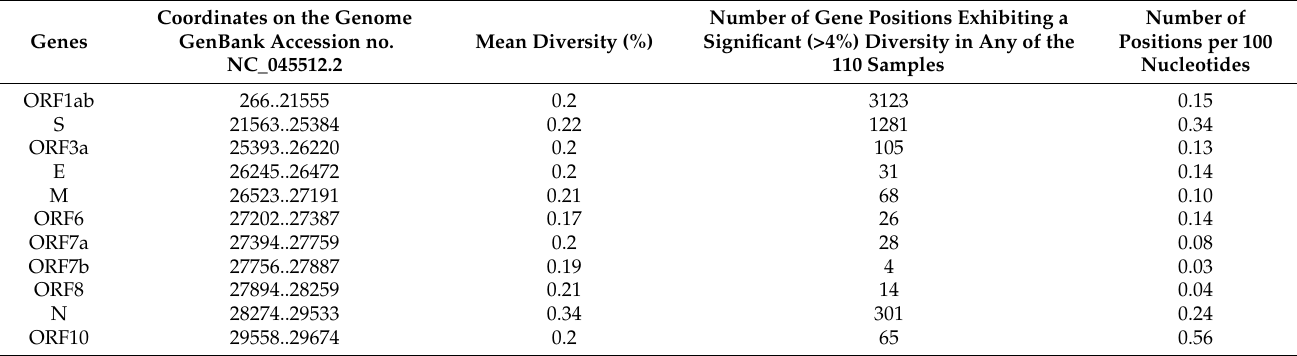
Figure 1. Intra-sample nucleotide diversity along the SARS-CoV-2 genome and hot spots of diversity. ( A ) Genome map and annotation. ( B ) Mean next-generation sequencing depth (in number of reads per nucleotide position) and mean intra-sample genetic diversity at nucleotide positions within the genome (%). Genome positions 1 to 130 and 29800 to 29903 are marked by yellow areas due to their sequencing depth lower than the threshold used in the present analyses. Hot spots of intra-sample genetic diversity are indicated by vertical dashed lines. Table 1. Intra-sample diversity per gene as a function of its corresponding